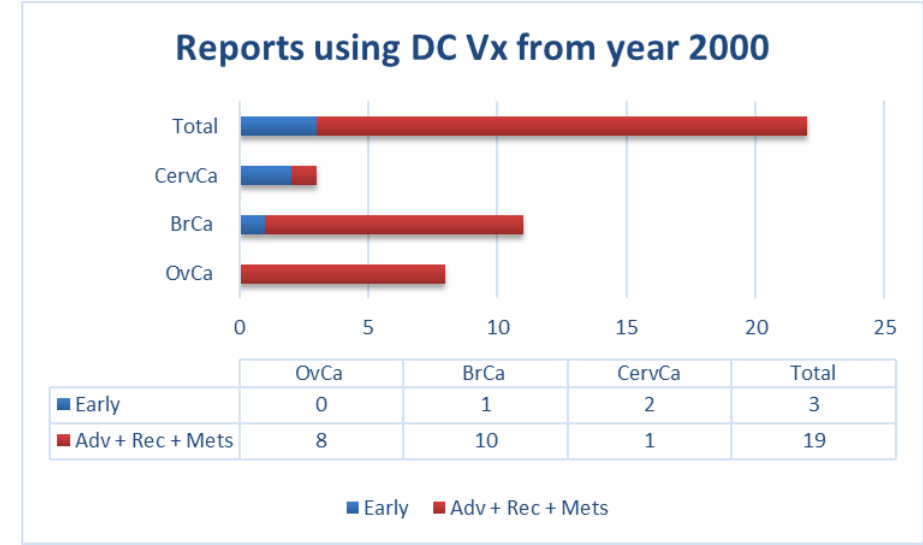
Figure 1. Number of reports in literature (source: PubMed) using dendritic cell (DC) vaccination in patients with the indicated gynecological and breast cancers (not exhaustive; according to data summarized in Supplementary Materials Table S1). Adv: advanced; BrCa: breast cancer; CervCa: cervical cancer; Mets: metastatic; OvCa: ovarian cancer; Rec: recurrent.